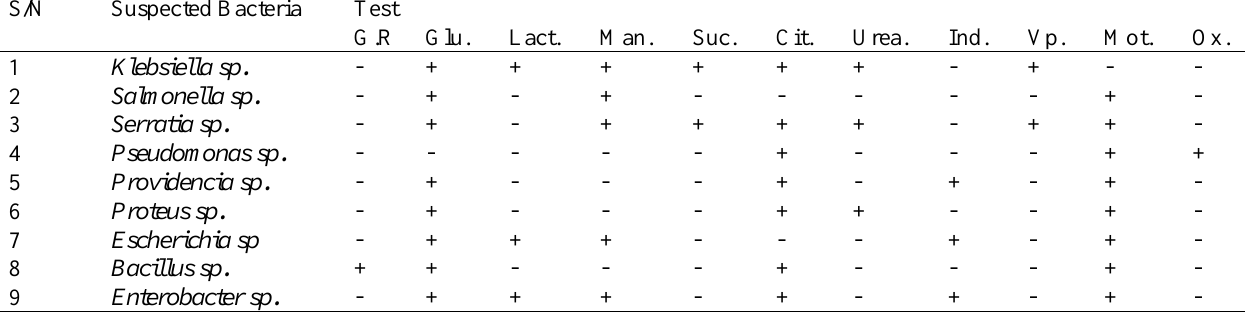
Table 4.2 Biochemical Identification of Isolated